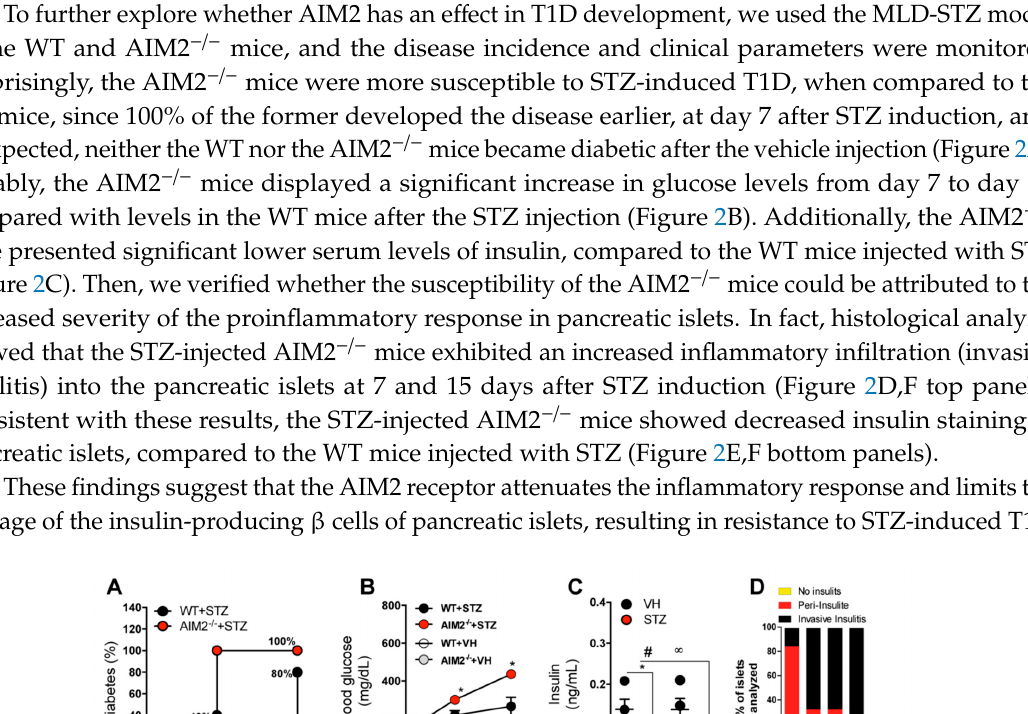
mice were injected with STZ (40 mg / kg) or a vehicle solution (VH, non-diabetic, 0 days after STZ) for five consecutive days, and clinical parameters were